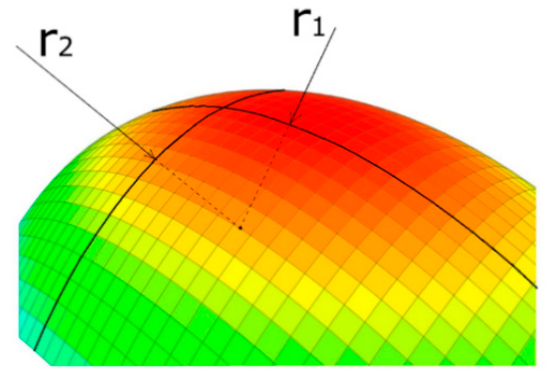
Figure 3. Liquid surface with two perpendicular surface trajectories of curvature r 1 and r 2 .